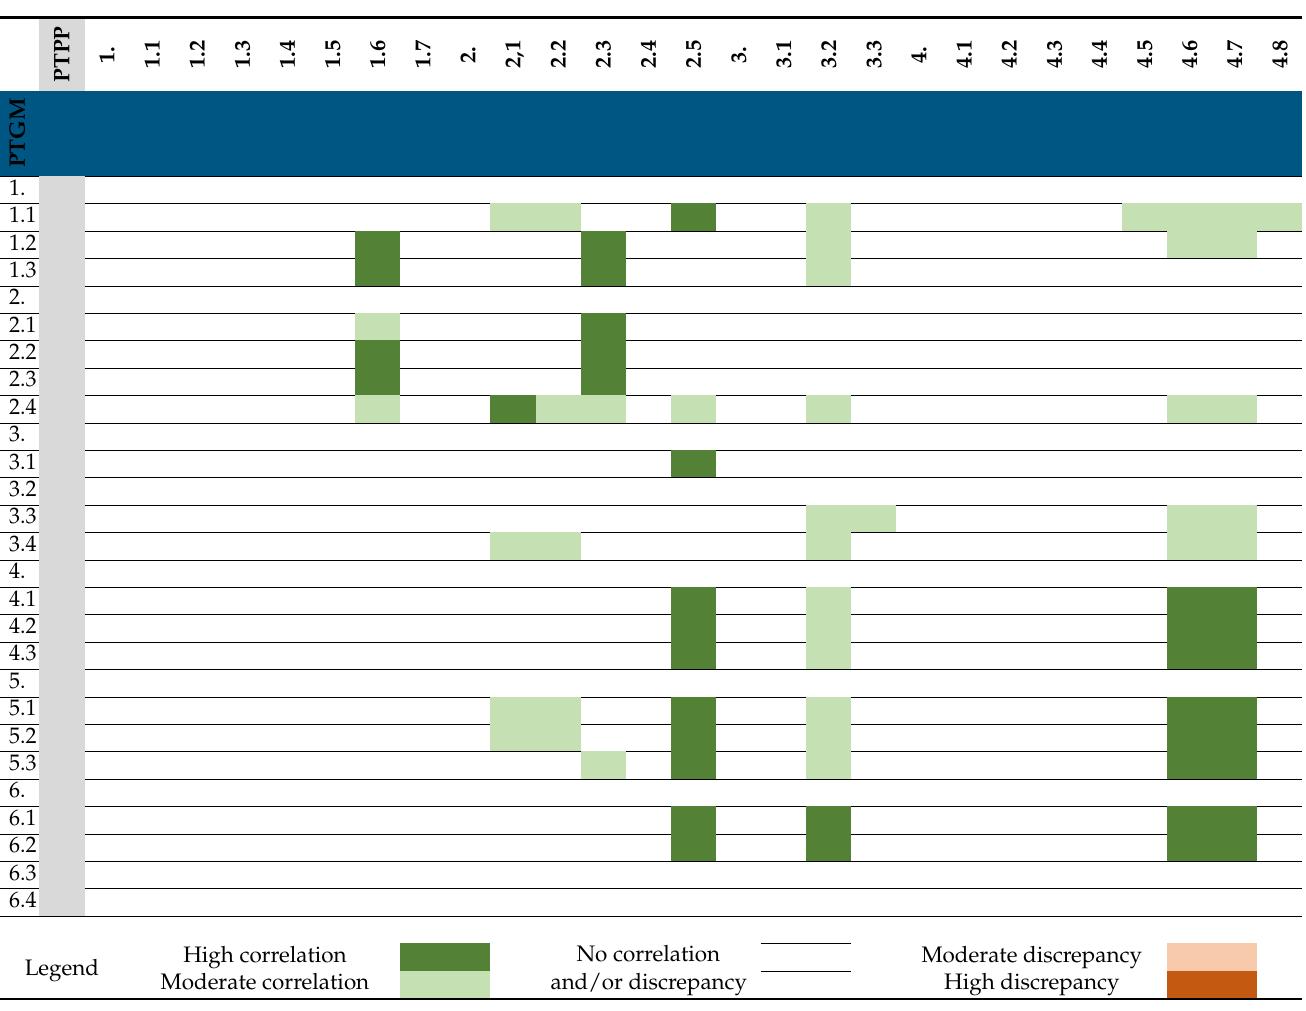
Table 15. Correlation matrix between the objectives of the PTPP of the PRG Revision and the objectives of the PTGM